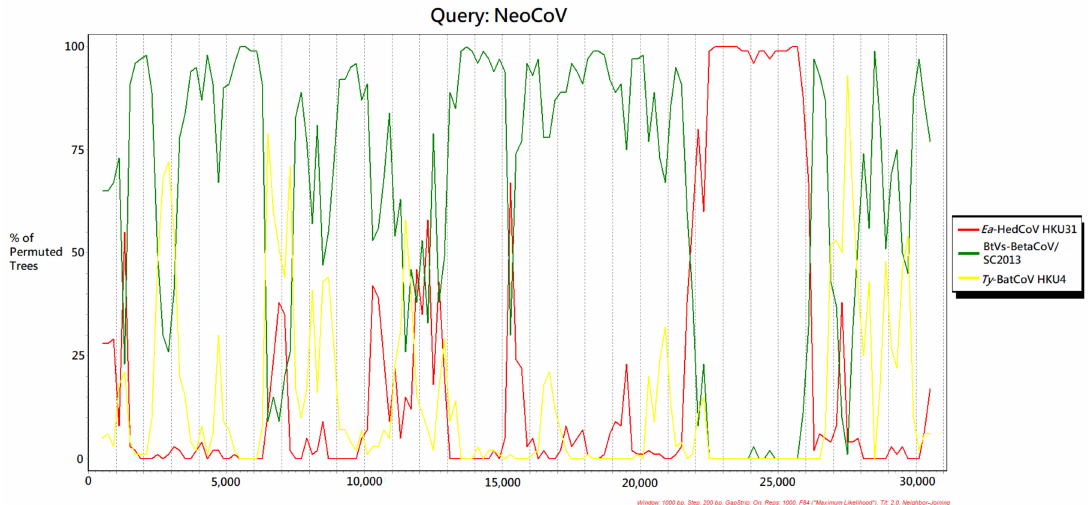
Figure 7. Detection of a potential recombination event by bootscan analysis. Simplot version 3.5.1 was used to perform the analysis with the F84 model, with a 1000 bp window size and 200 bp moving step. NeoCoV was chosen as the query sequence and compared with other Merbecoviruses including Ea -HedCoV HKU31 (red), BtVs-BetaCoV / SC2013 (green) and Ty -BatCoV HKU4